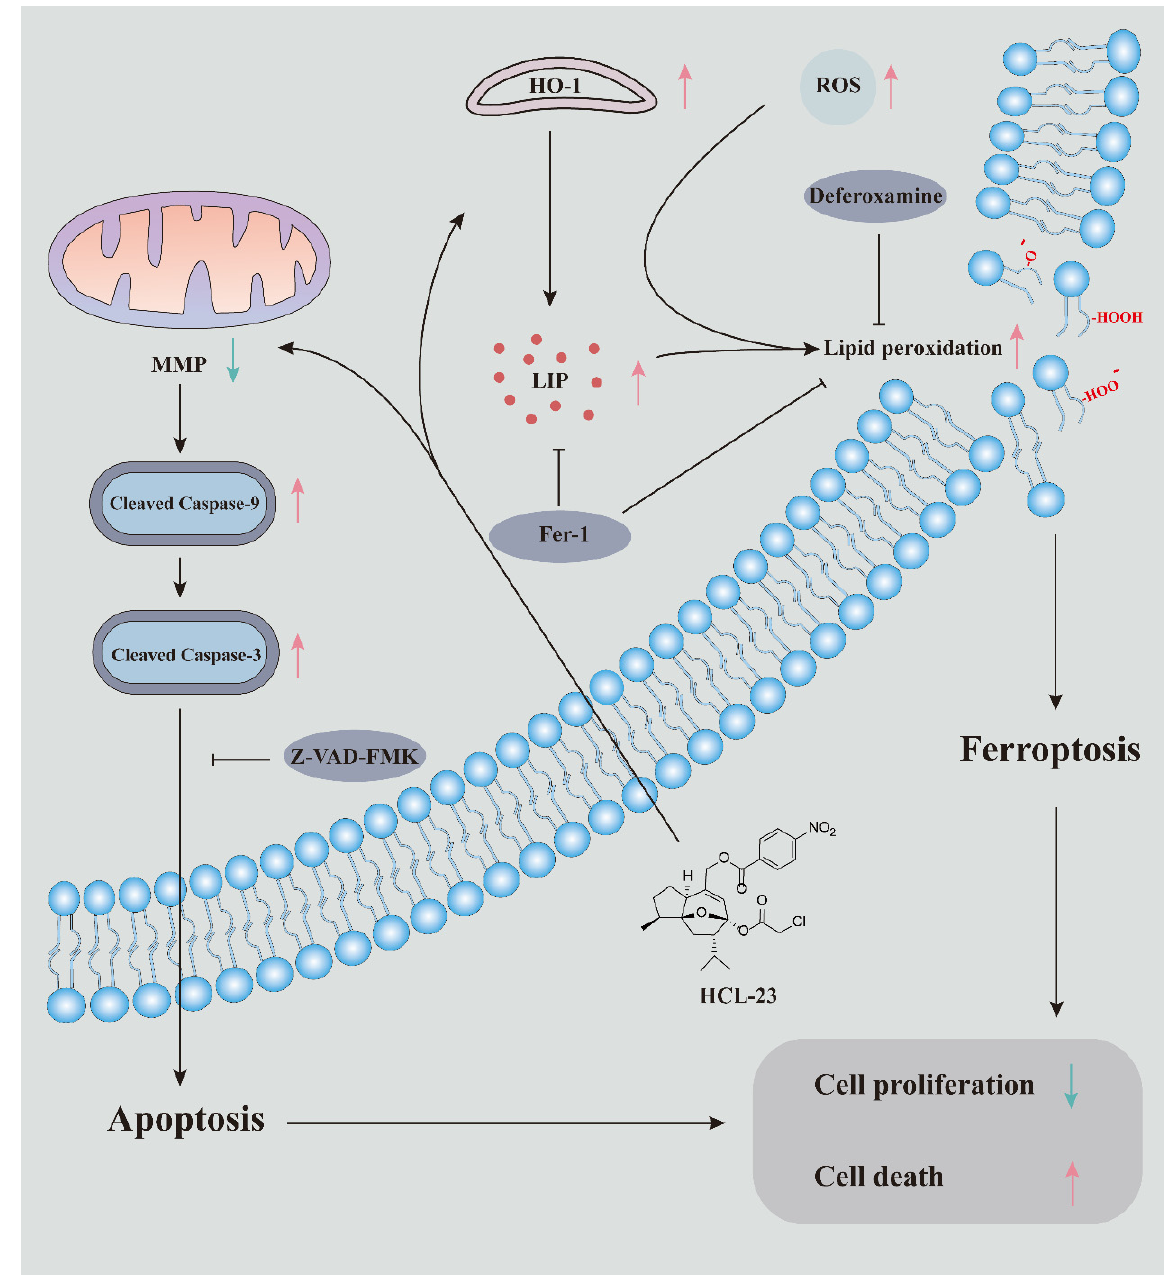
Figure 9. HCL-23 induces caspases-mediated apoptosis and HO-1-dependent ferroptosis in MDA- MB-231 cells.